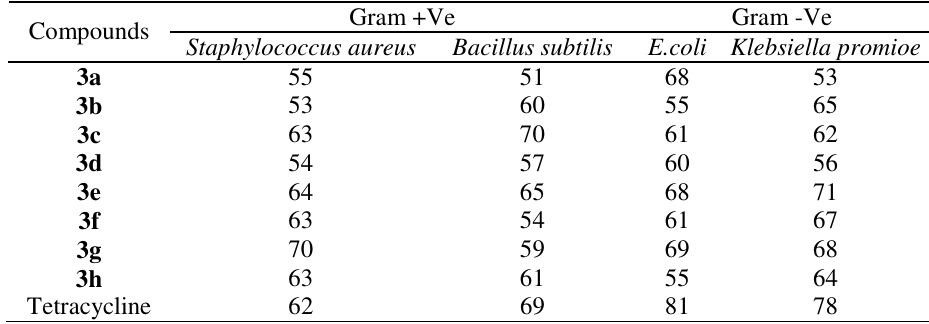
Table 4. Antibacterial activity of compounds ( 3a-h )